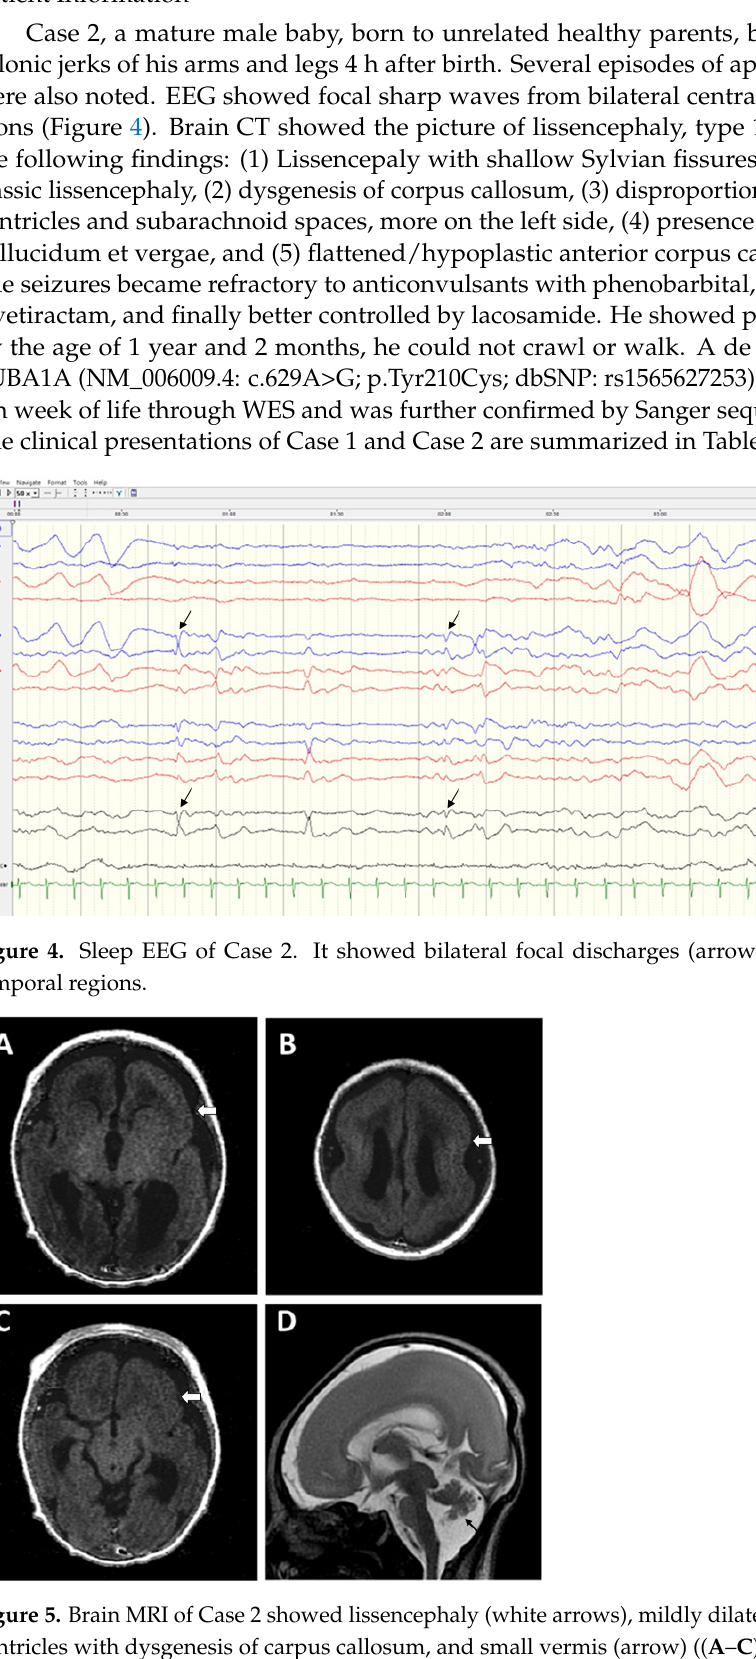
Figure 5. Brain MRI of Case 2 showed lissencephaly (white arrows), mildly dilated posterior horns of ventricles with dysgenesis of carpus callosum, and small vermis (arrow) (A-C: T1WI, D: T2WI).